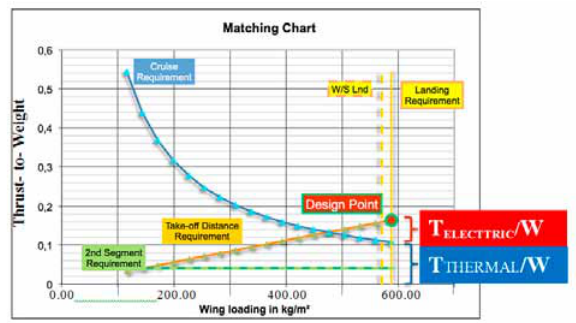
Fig. 12. “Matching chart” plot showing the benefit of the over boost at take-off. From (Fioriti